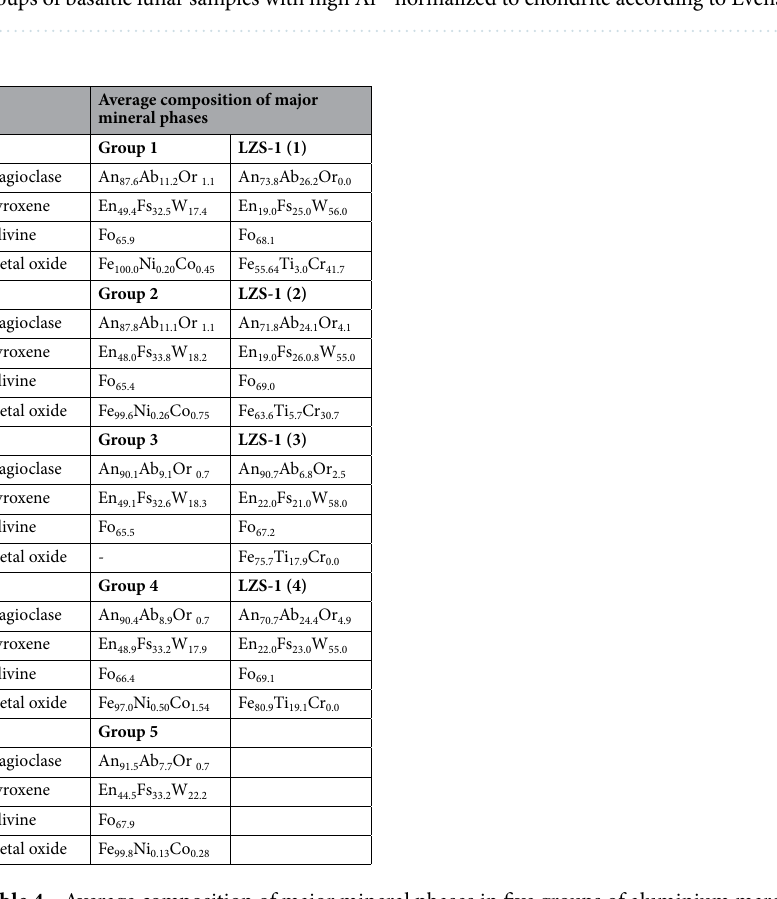
Table 4. Average composition of major mineral phases in five groups of aluminium mare basalt samples from the lunar surface 25 and in LZS-1 obtained with the SEM–EDX.